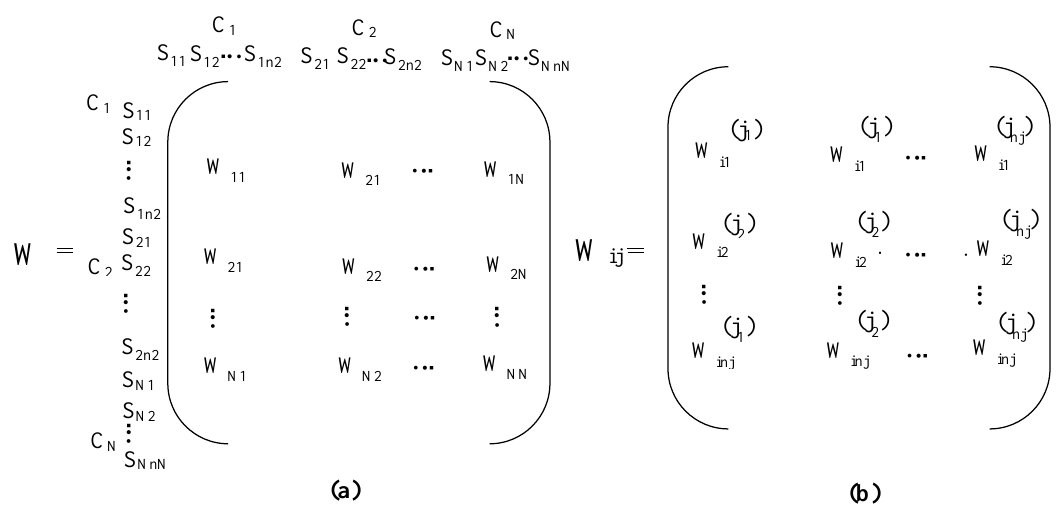
Figure 3. ANP entry-matrices: ( a ) the network supermatrix, ( b ) the network sub-matrix, [19].